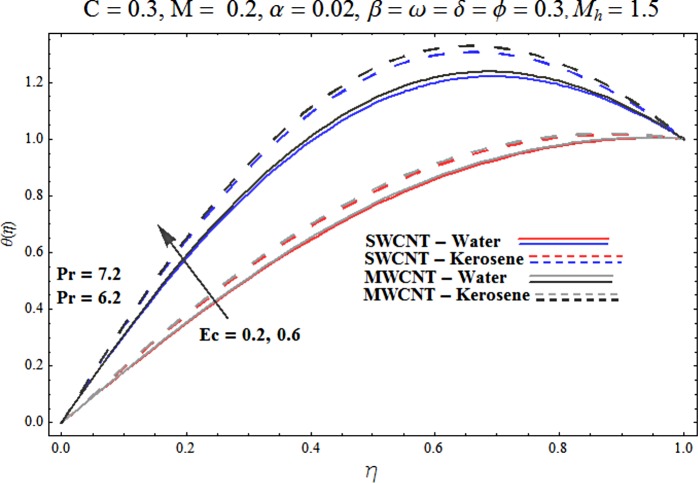
Effect of ϕ on θ.